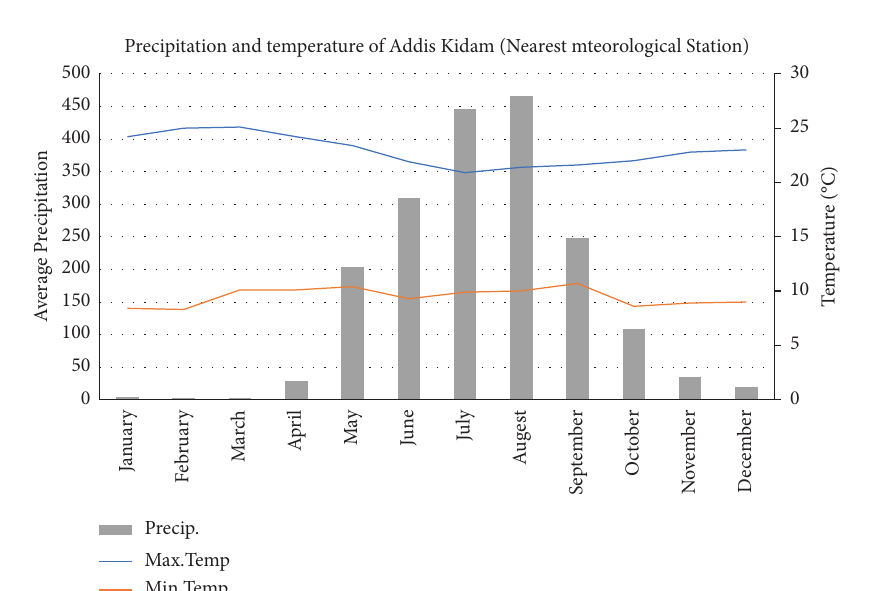
Figure 2: Climate diagram of Addis Kidam district (from 2011 to 2020). Table 1: Species list with synoptic cover-abundance value for species having a value of ≥ 1 in at least one community.